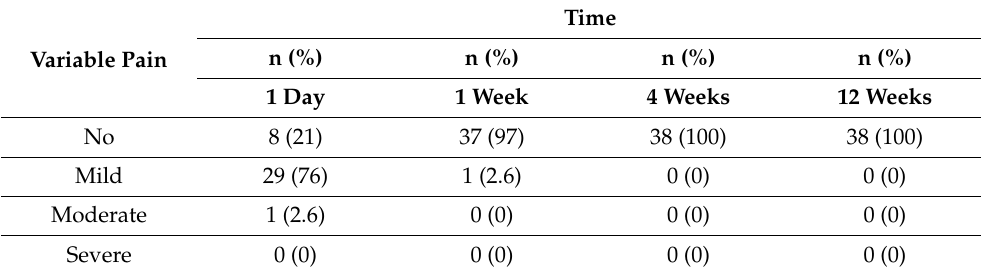
Table 3. Pain at 1 day, weeks 1, 4 and 12 after treatment.